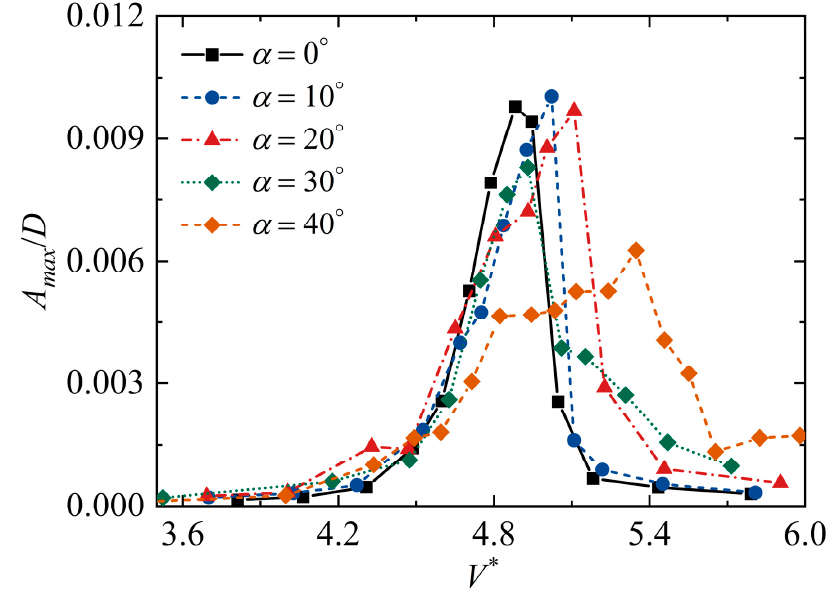
Figure 14. The variation in A * versus V * for different α .